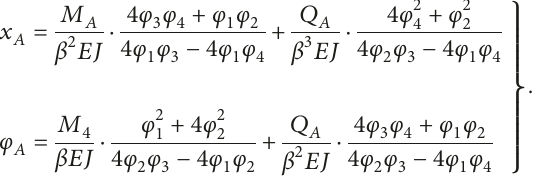
Figure 2: Top view of the test model.